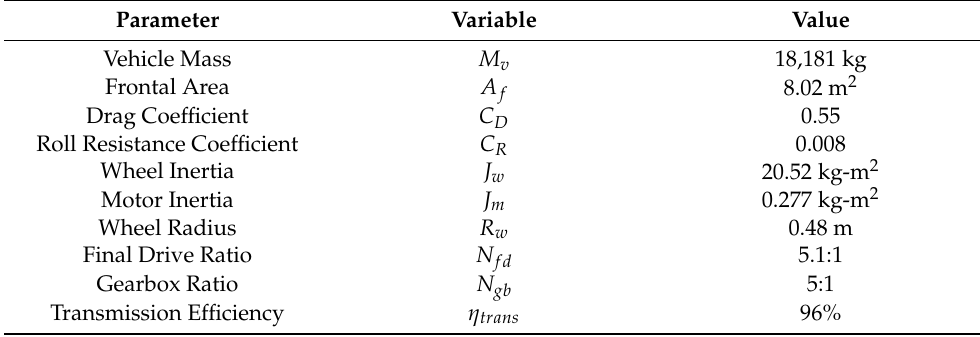
Table 1. Vehicle model physical